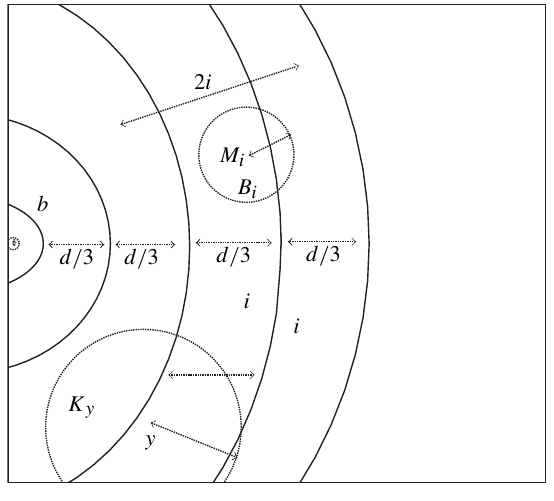
Figure 4.1. Description of the domain (cid:1) l and the splitting used in the majorization of the local